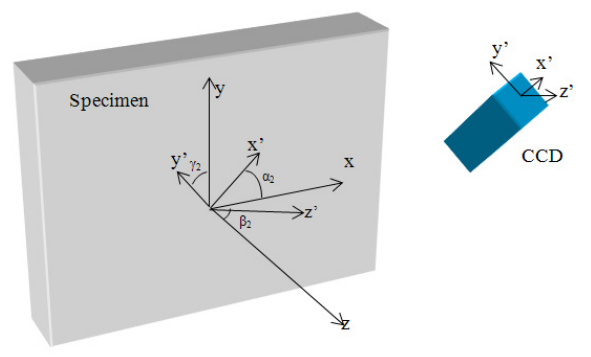
Figure 2: Schematic of the geometrical set-up with the CCD camera and the specimen.